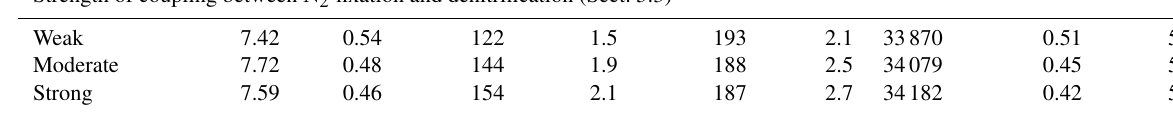
are equal to the global rate 3